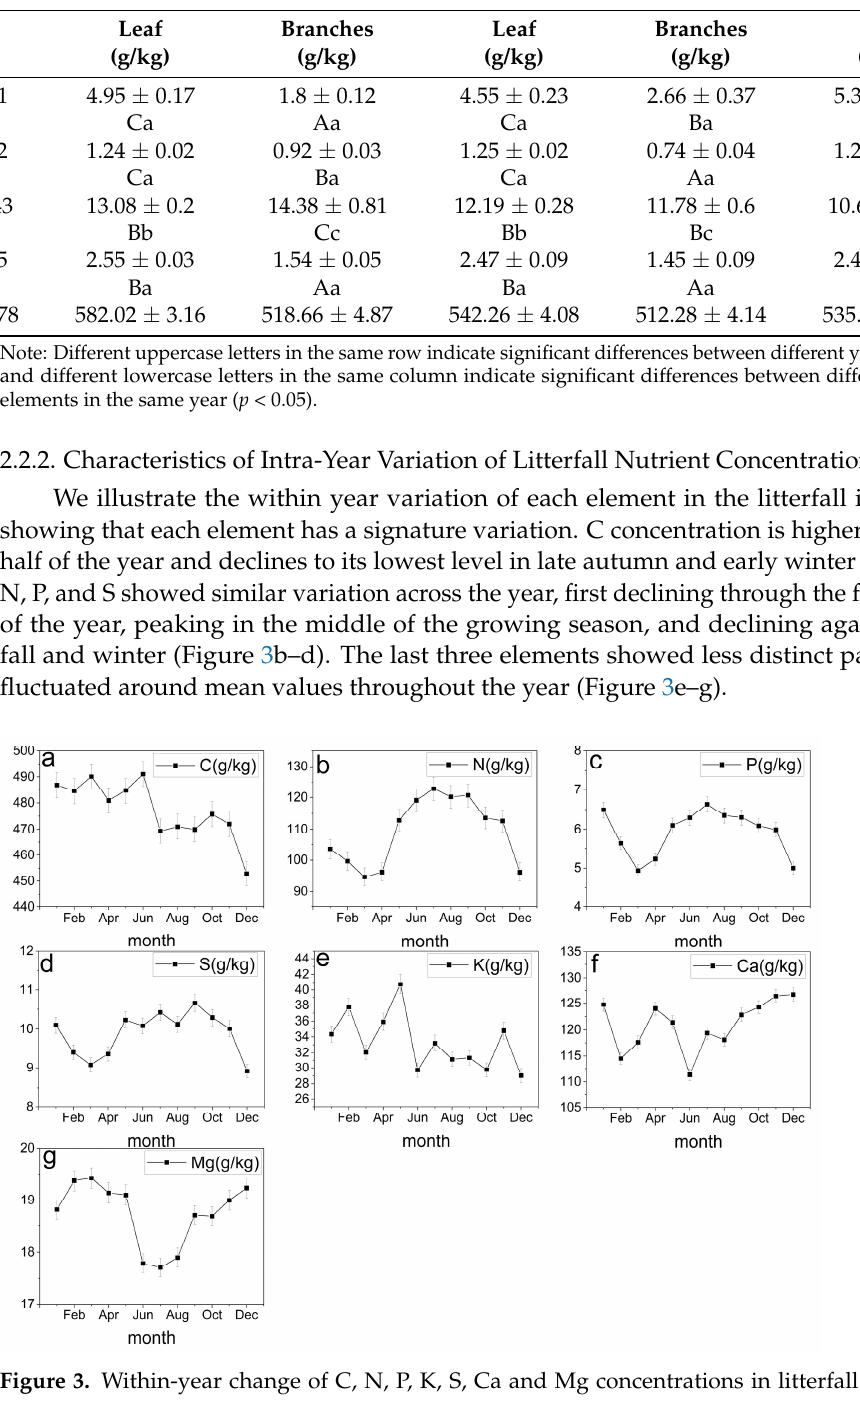
Figure 3. Within-year change of C, N, P, K, S, Ca and Mg concentrations in litterfall. ( a ) Within-year change of C element concentration. ( b ) Within-year change of N element concentration. ( c ) Within-year change of P element concentration. ( d ) Within-year change of S element concentration. ( e ) Within-year change of K element concentration. ( f ) Within-year change of Ca element concentration. ( g ) Within-year change of Mg element concentration.